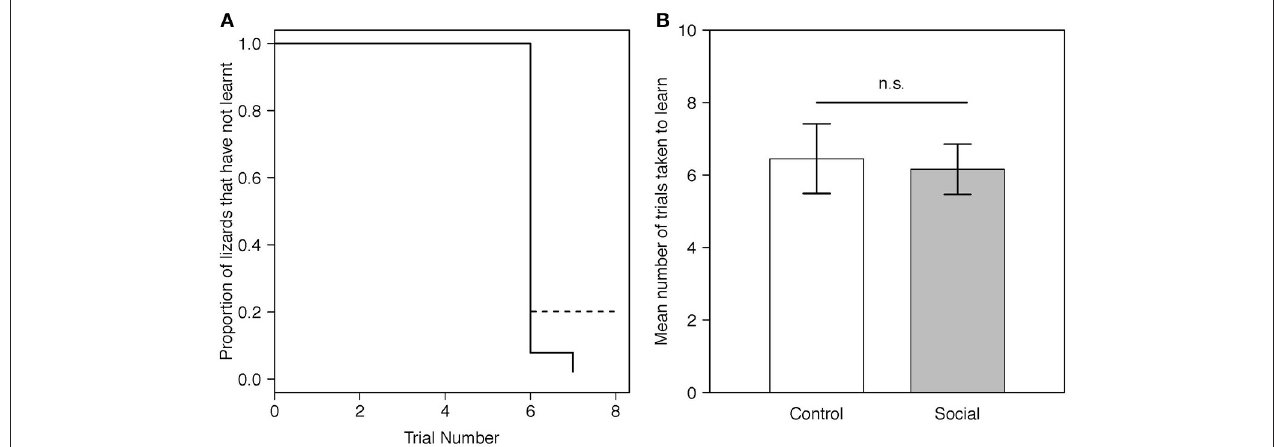
FIGURE 2 | (A) Predicted proportion of lizards across trials in the social learning treatment ( n = 15) and control group ( n = 13) that did not learn the instrumental task. Predictions were averaged across both batches. The solid line represents the social learning treatment, the dashed line the control group. (B) Predicted mean number of trials taken to learn for lizards in the social learning treatment ( n = 15) and control group ( n = 13) in the instrumental task ( Table 1A ). For visualization purposes, batch number was set to 1. Gray bars represent the social learning treatment; white bars represent the control group. Error bars are one standard error.